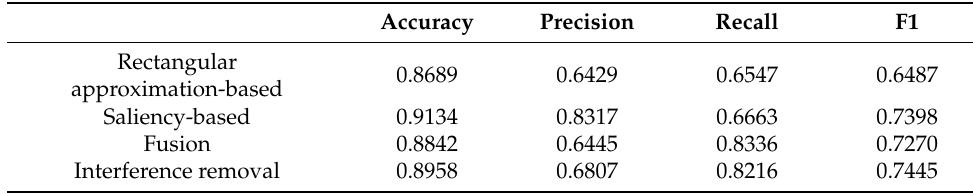
Table 4. Image II detection results.